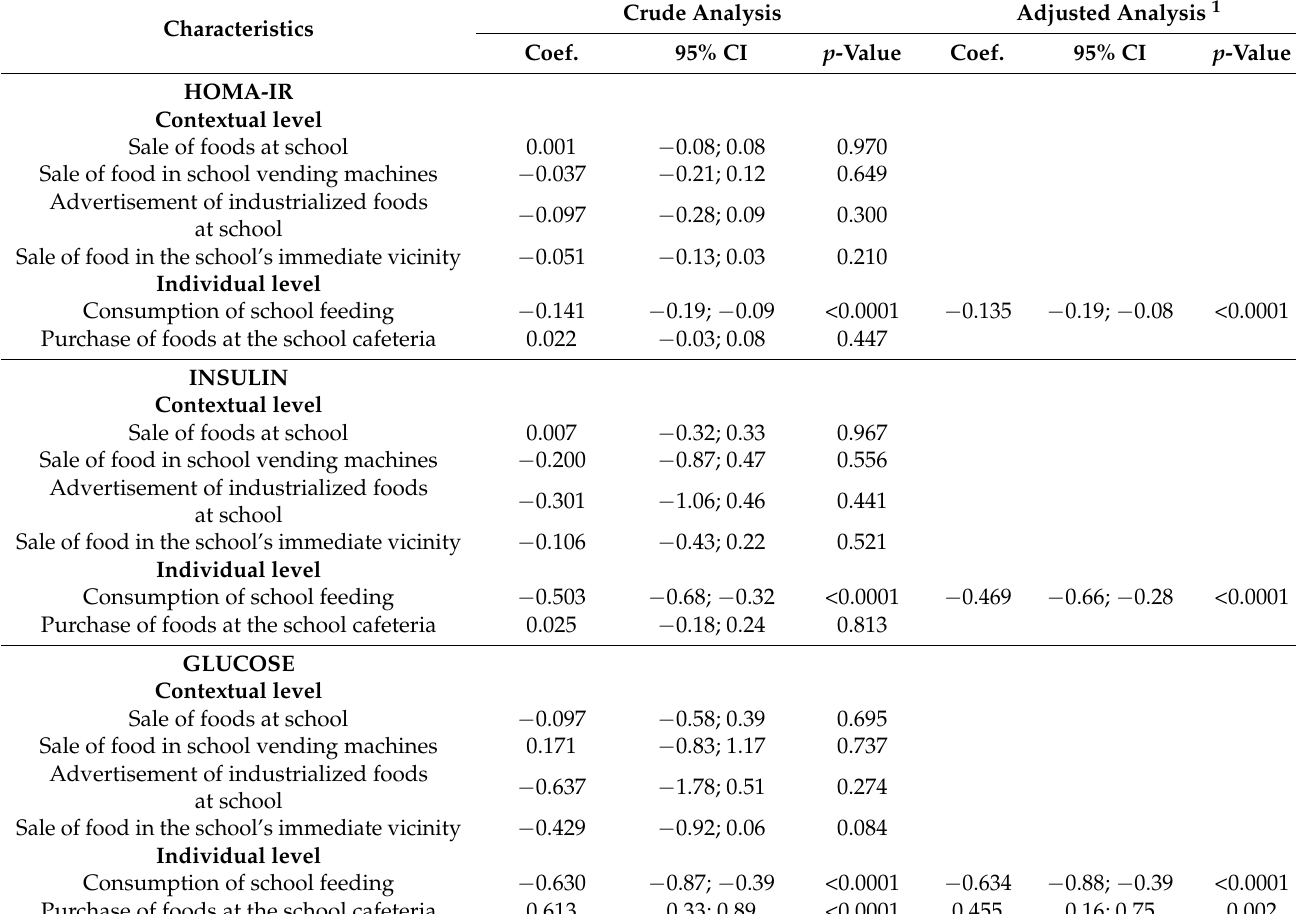
Table 4. Multilevel linear regression of contextual and individual level and HOMA-IR, insulin, and glucose markers. Study of Cardiovascular Risks in Adolescents (ERICA), Brazil, 2013–2014. Crude Analysis Characteristics